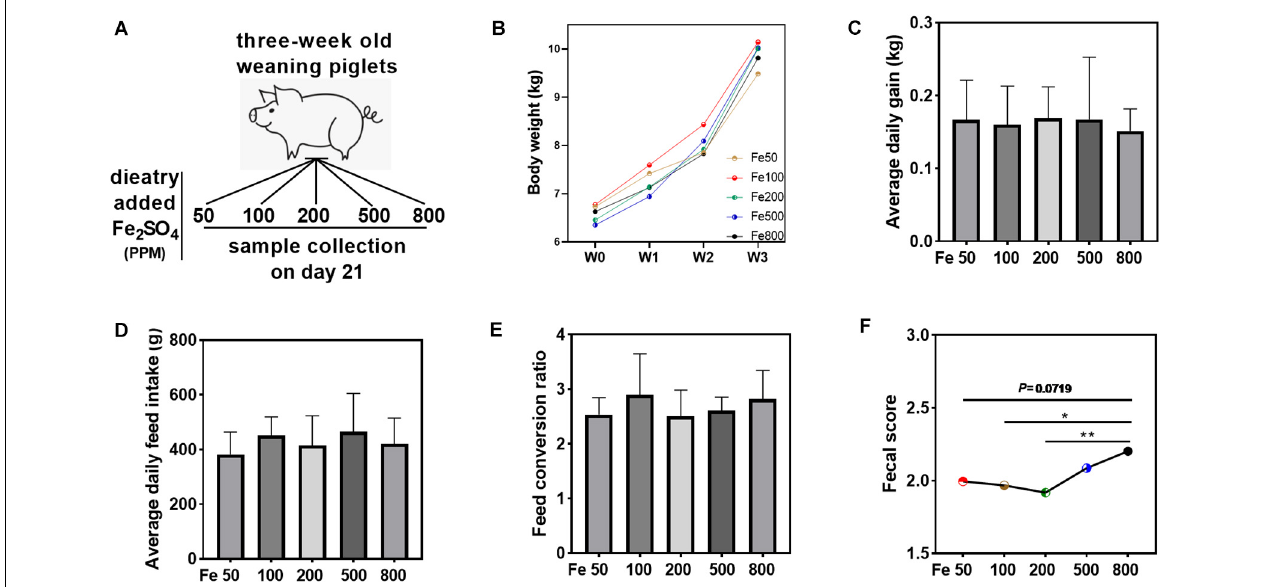
FIGURE 1 | Dietary iron had no significant effects on the growth performance but increased fecal consistency score. Growth performance and fecal consistency scores were evaluated in each group. Schematic showing dietary iron treatment of each group (A) . Body weight (B) , average daily gain (C) , average daily feed intake (D) , and feed conversion ratio (E) were similar among the five groups. The average fecal score of the 21 days (F) in the Fe800 group was also higher than that in the other groups. Ordinary one-way ANOVA or Kruskal–Wallis test was used for the statistical analysis among different groups. Data were presented as mean ± SD. ∗ P < 0 . 05, ∗∗ P < 0 .